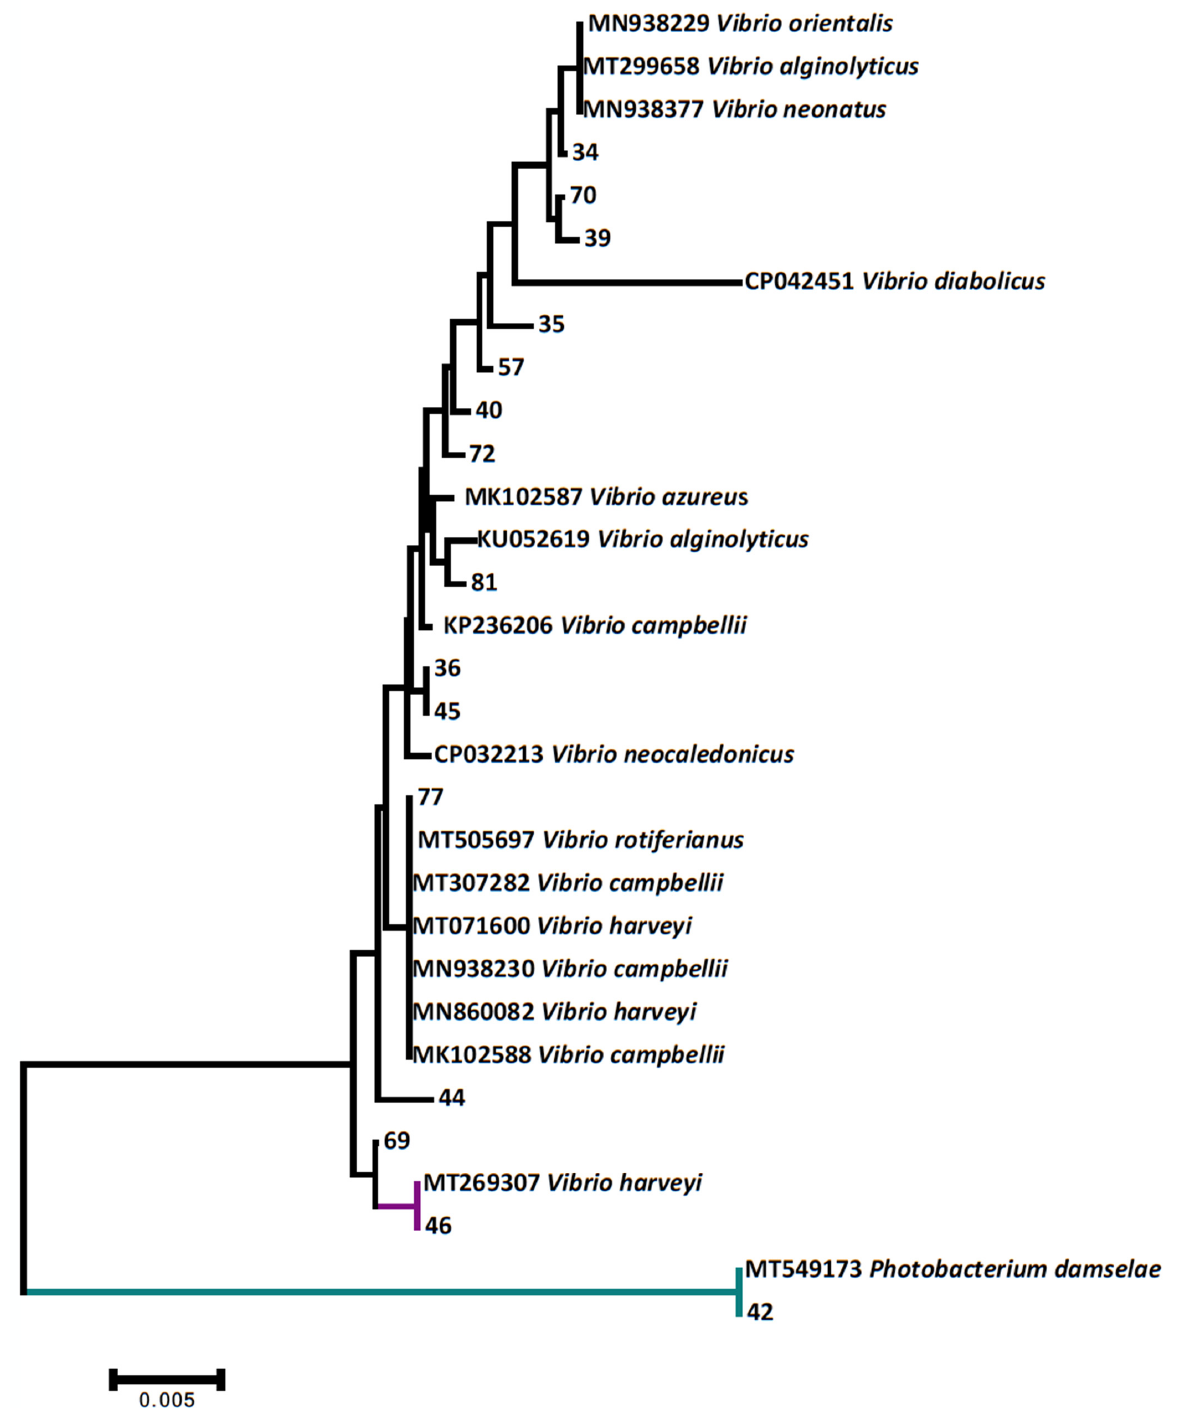
Figure 1. Maximum likelihood phylogenetic dendrogram of the detected cultured bacteria in comparison to closely related haplotypes retrieved from GenBank, based on the 16 s rRNA gene. With the exception of Vibrio neocaledonicus , all the Vibrio taxa included in the dendrogram are considered validly published under the International Code of Nomenclature of Bac ‐ teria.